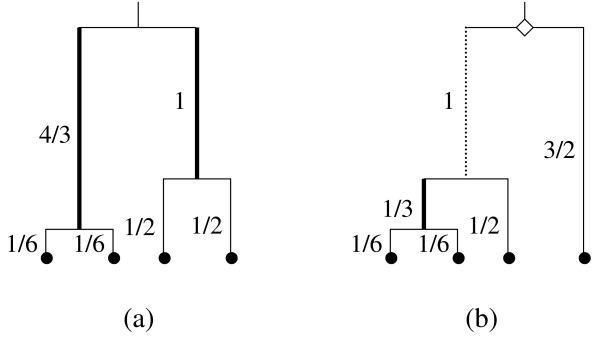
Representative symmetrical (a) and asymmetrical (b) genealogies for four sampled sequences. In all, there are six symmetrical and 12 asymmetrical labeled genealogies for these four sequences [8,45]. This figure illustrates how the shape of a genealogy affects whether a mutation will lead to a singleton or shared polymorphism. This heterogeneity contributes to the variance of θ for the three new methods. This contribution is in addition to the heterogeneity of the genealogical branch lengths and Poisson mutation process [4,5]. The diamond highlights the common ancestor of the (n - 1) basal group of the asymmetrical genealogy. The dotted and thin solid lines mark the basal branch leading to this ancestor and the external branches, respectively, where a mutation will result in a singleton. The thick solid lines denote the other internal branches where a mutation will lead to a shared polymorphism. Expected branch lengths are given in units of scaled coalescent time next to each internode (those of the symmetrical genealogy are specific for its particular labeled history). Although both genealogies have an expected overall length of 11/3, the total length of the internal branches where a shared polymorphism can arise is 7/3 for (a) but only 1/3 for (b).